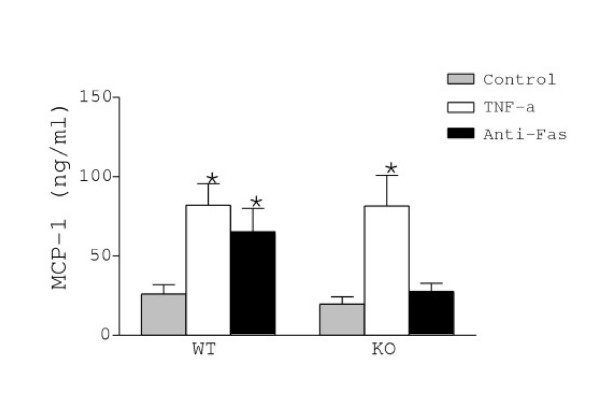
Release of MCP-1 by WT and KO astrocytes was measured in supernatants by ELISA. MCP-1 release was up-regulated by TNF-α in astrocytes from WT and KO mice, whereas Fas activation increased MCP-1 release only in WT astrocytes. Values represent the mean +/- s.e.m. of at least three independent experiments. Statistical differences were determined by Student's t-test when comparing treatments to control cells (* p < 0.05).